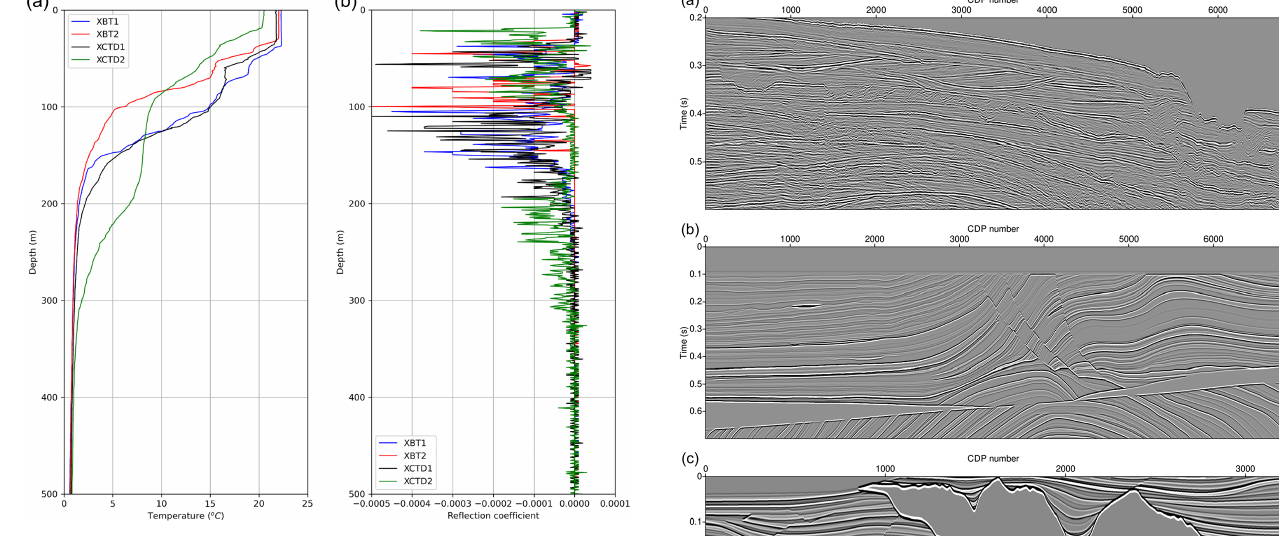
Figure 4. (a) Temperature and (b) reflection coefficient profiles ob- tained using two XBTs and two XCTDs.